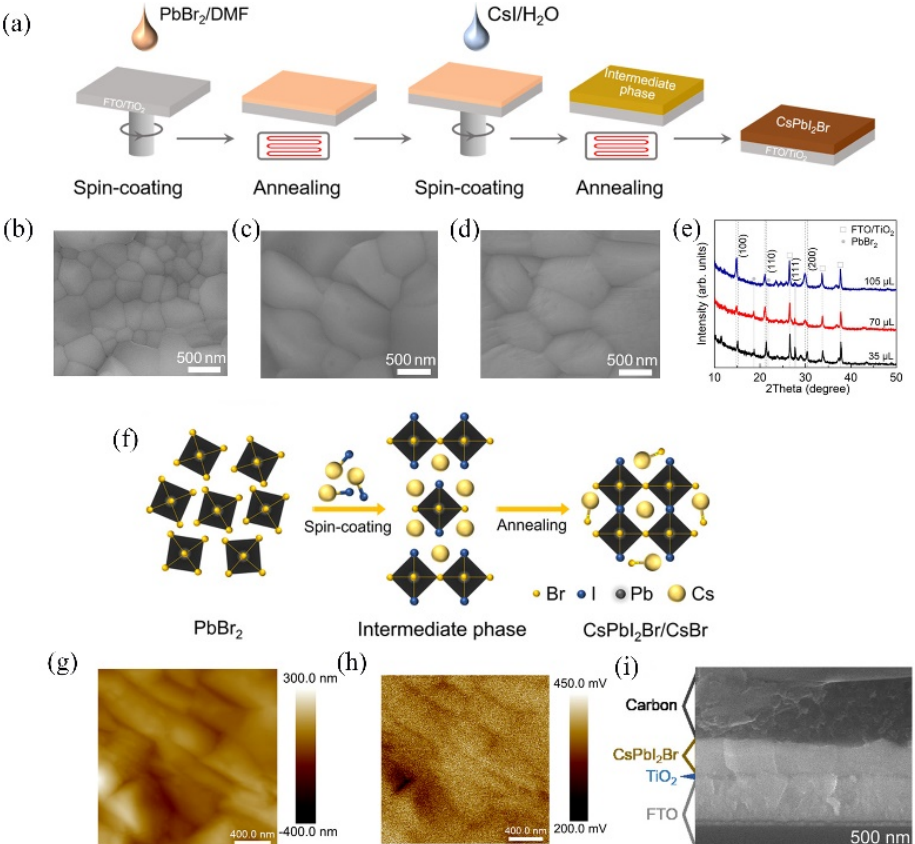
Figure 8. ( a ) Schematic illustration involving the intermediate-phase-assisted two-step solution process. SEM images of CsPbI 2 Br films prepared with ( b ) 35 µ L, ( c ) 70 µ L, and ( d ) 105 µ L CsI/H 2 O. ( e ) XRD patterns of CsPbI 2 Br films prepared with 35 µ L, 70 µ L, and 105 µ L CsI/H 2 O. ( f ) Formation mechanism of CsPbI 2 Br film with excess CsBr by intermediate-phase-assisted two-step solution process. ( g ) AFM and ( h ) Kelvin probe force microscope images of CsPbI 2 Br films fabricated by intermediate phase-assisted sequential process. ( i ) Cross-sectional SEM image of the resulting C- IPSC-based CsPbI 2 Br films. Reproduced with permission [121]. Copyright 2022, Wiley-VCH Publications.